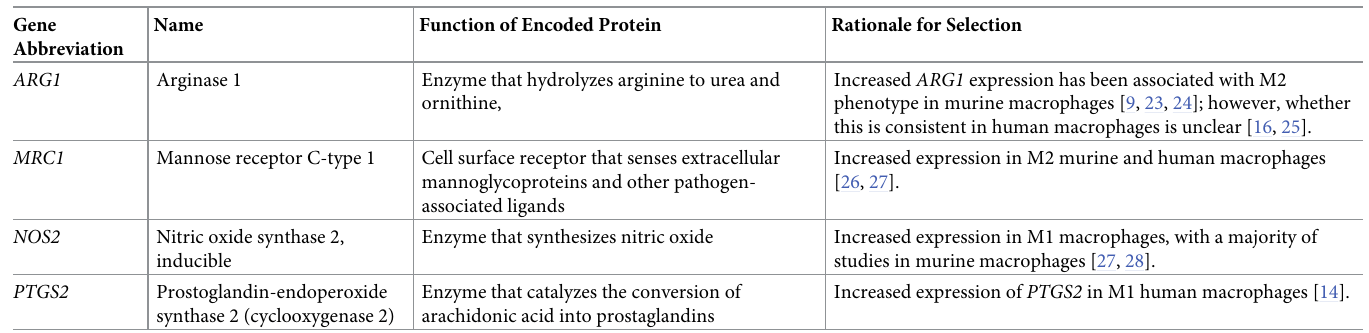
Table 1. Genes selected for RT-qPCR and rationale for their